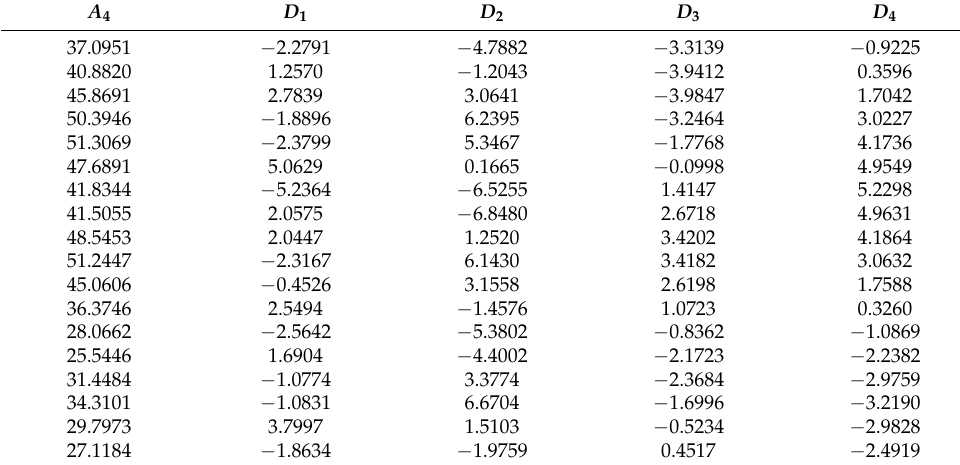
Table 4. Four-level wavelet decomposition of V 3 .